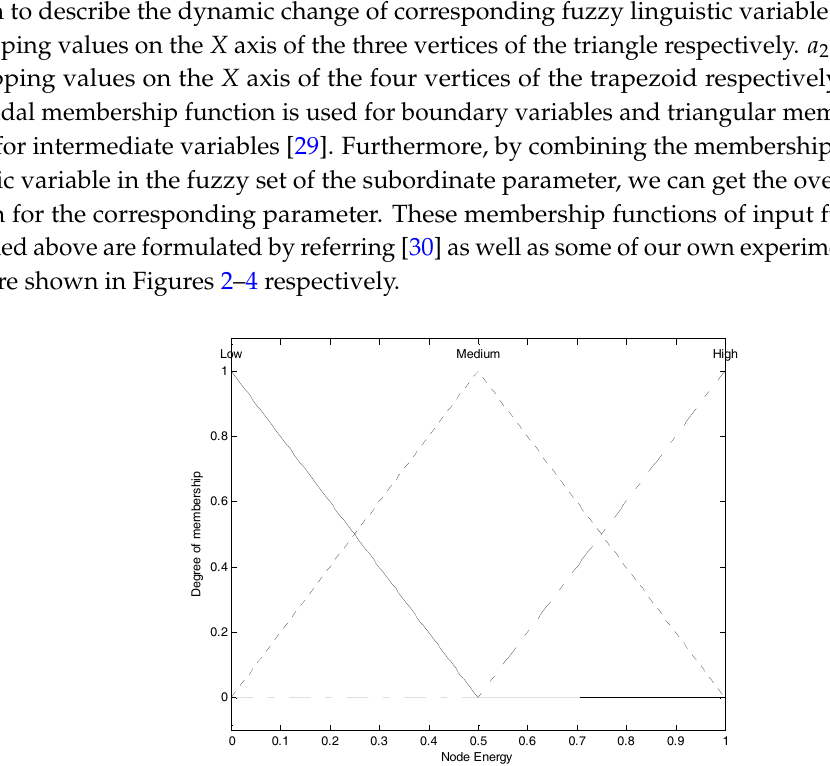
Figure 3. Nodes degree membership function.